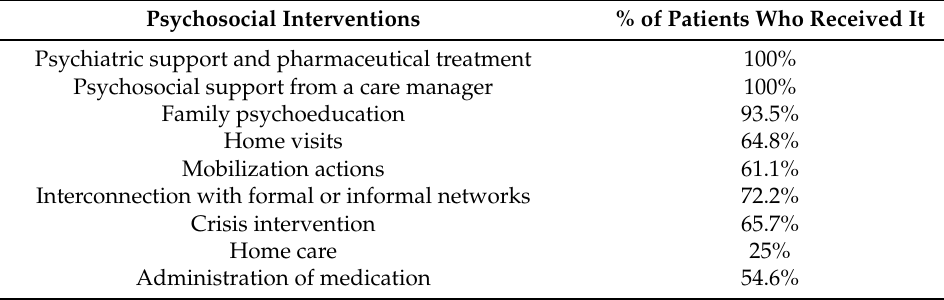
Table 2. Psychosocial interventions of the